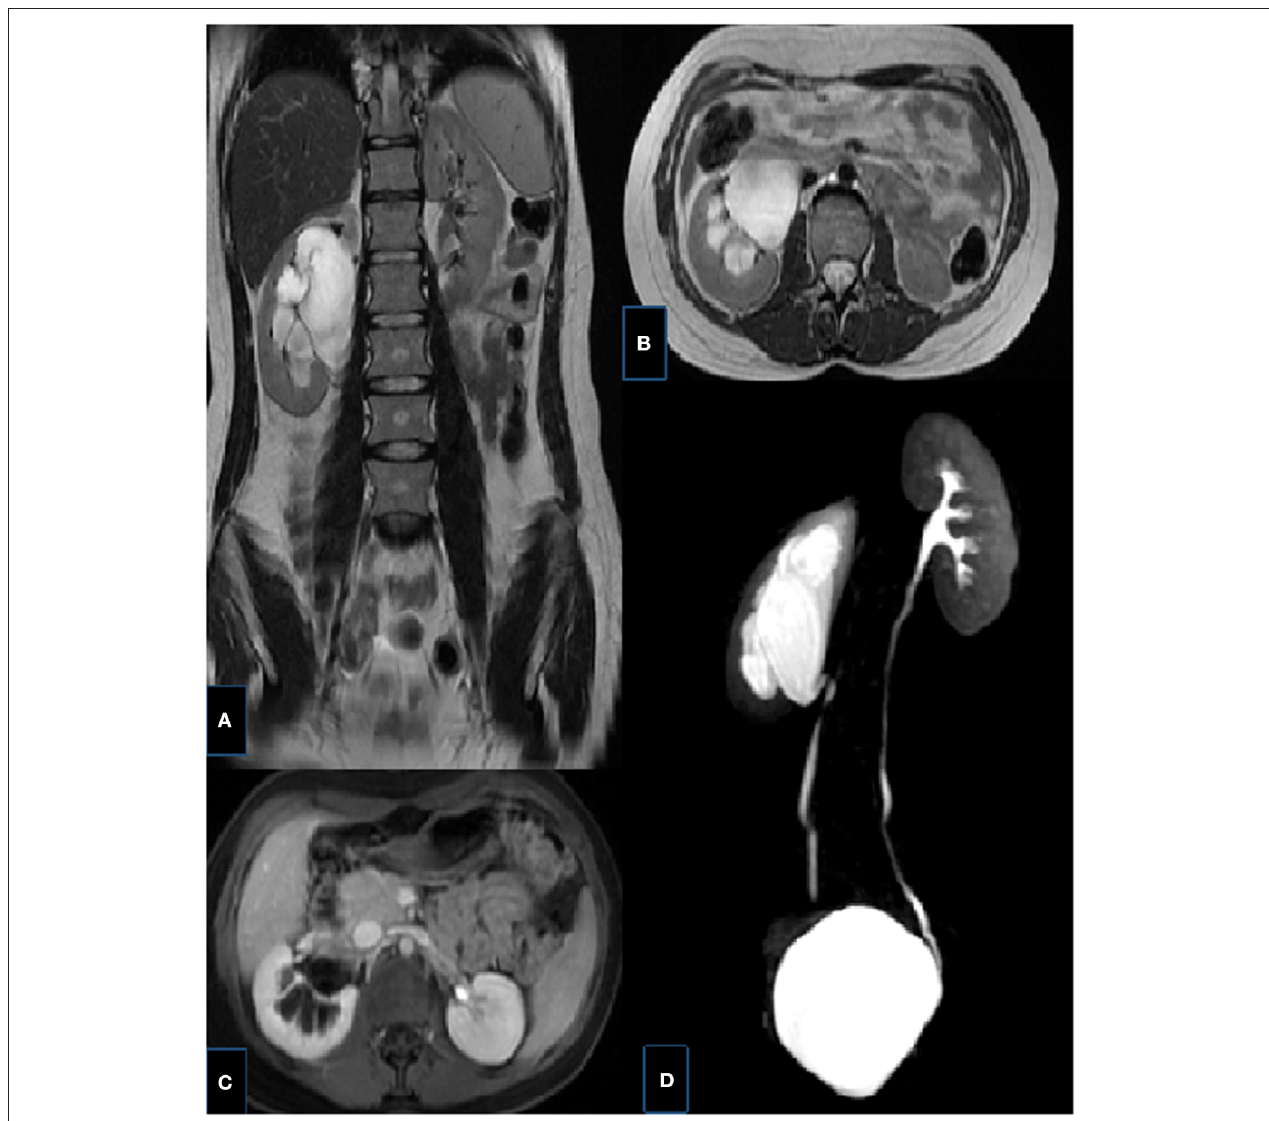
FIGURE 9 | Right UPJ obstruction in a 14-year-old girl. (A,B) T2-weighted fast spin-echo coronal (a) and axial (b) MR images showing right renal collecting system dilatation, pelvis is extrarenally located, the thickness of renal parenchyma is decreased and corticomedullary differentiaton is lost. (C) Axial post-contrast excretory phase showing delayed excretion in the right renal collecting system, notice the contrast material in the left pelvis. (D) MIP MR image showing UPJ obstruction with kinking and angulation at the UPJ and a normal caliber ureter, left kidney is